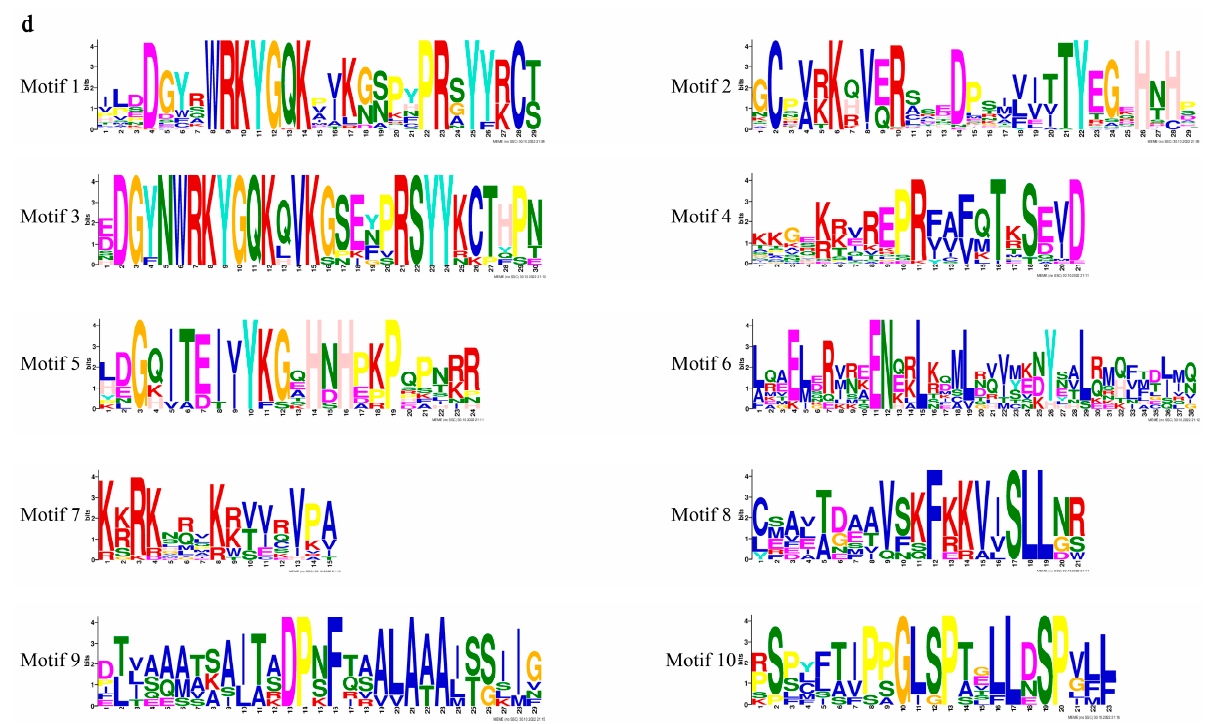
Figure 3. Gene structure and conserved motif analysis of SsWRKY gene family. ( a ) Phylogenetic tree of SsWRKYs constructed using MEGA7.0 software; ( b ) Motif compositions of SsWRKY proteins. Ten motifs are represented by different colored boxes numbered 1–10; ( c ) Exon–intron structural analysis of SsWRKY genes. Green boxes, yellow boxes, and black lines represent UTR, CDS, and introns, respectively; ( d ) Sequence logos foor motif 1-10.